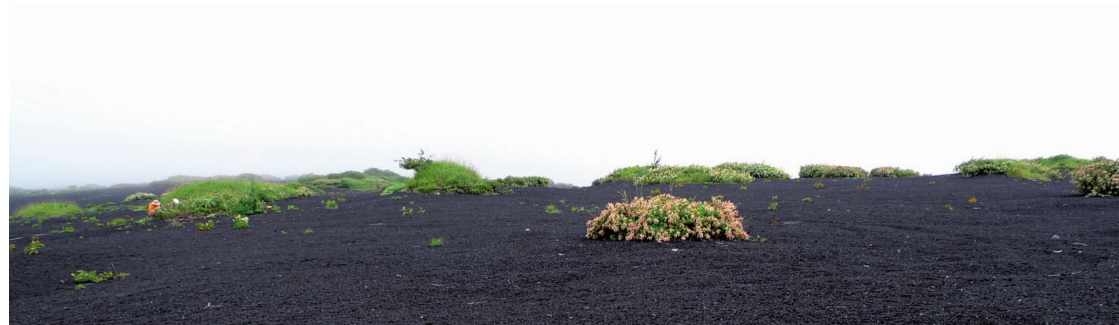
Figure 1. Patches of Polygonum cuspidatum on barren scoria gravel in the slopes of Mt Fuji, Japan at 1500 m